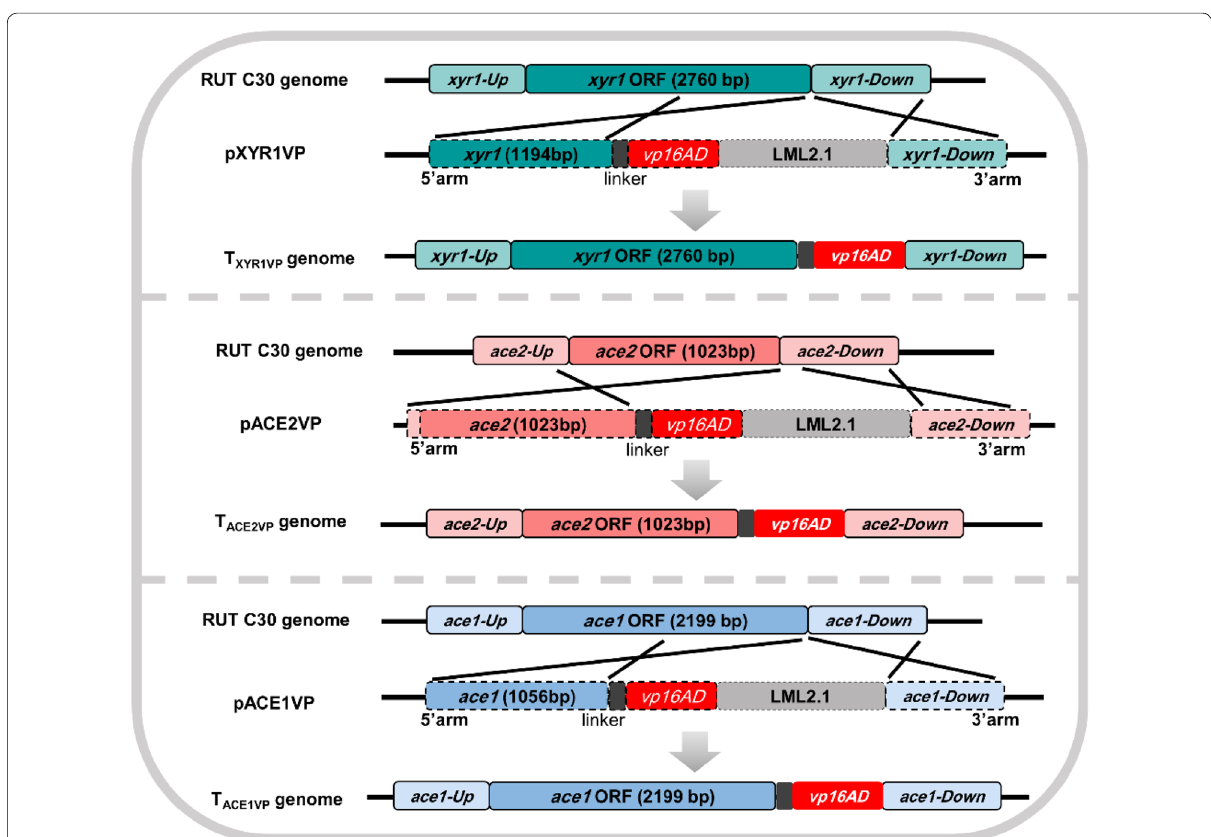
Fig. 1 Construction and transfection of the ETAs. A short flexible linker (GGGGSGGGGS) and activation domain of VP16 (vp16AD) were fused with the C terminus of the natural proteins, ACE2 (aa 1–341), ACE1 (aa 1–733), or XYR1 (aa 1–920). The C-terminal last encoding codon of each natural protein was fused to the linker and then fused to the activation domain of VP16 by Seamless Cloning and Assembly Kit (TransGen, Beijing, China). ETAs were used to replace the natural regulators in T. reesei RUT C30. Transformants T ACE2VP , T ACE1VP , and T XYR1VP were obtained after xylose-induced marker rescue